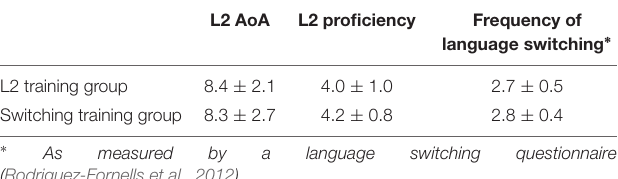
TABLE 6 | Language background information for participants in Experiment